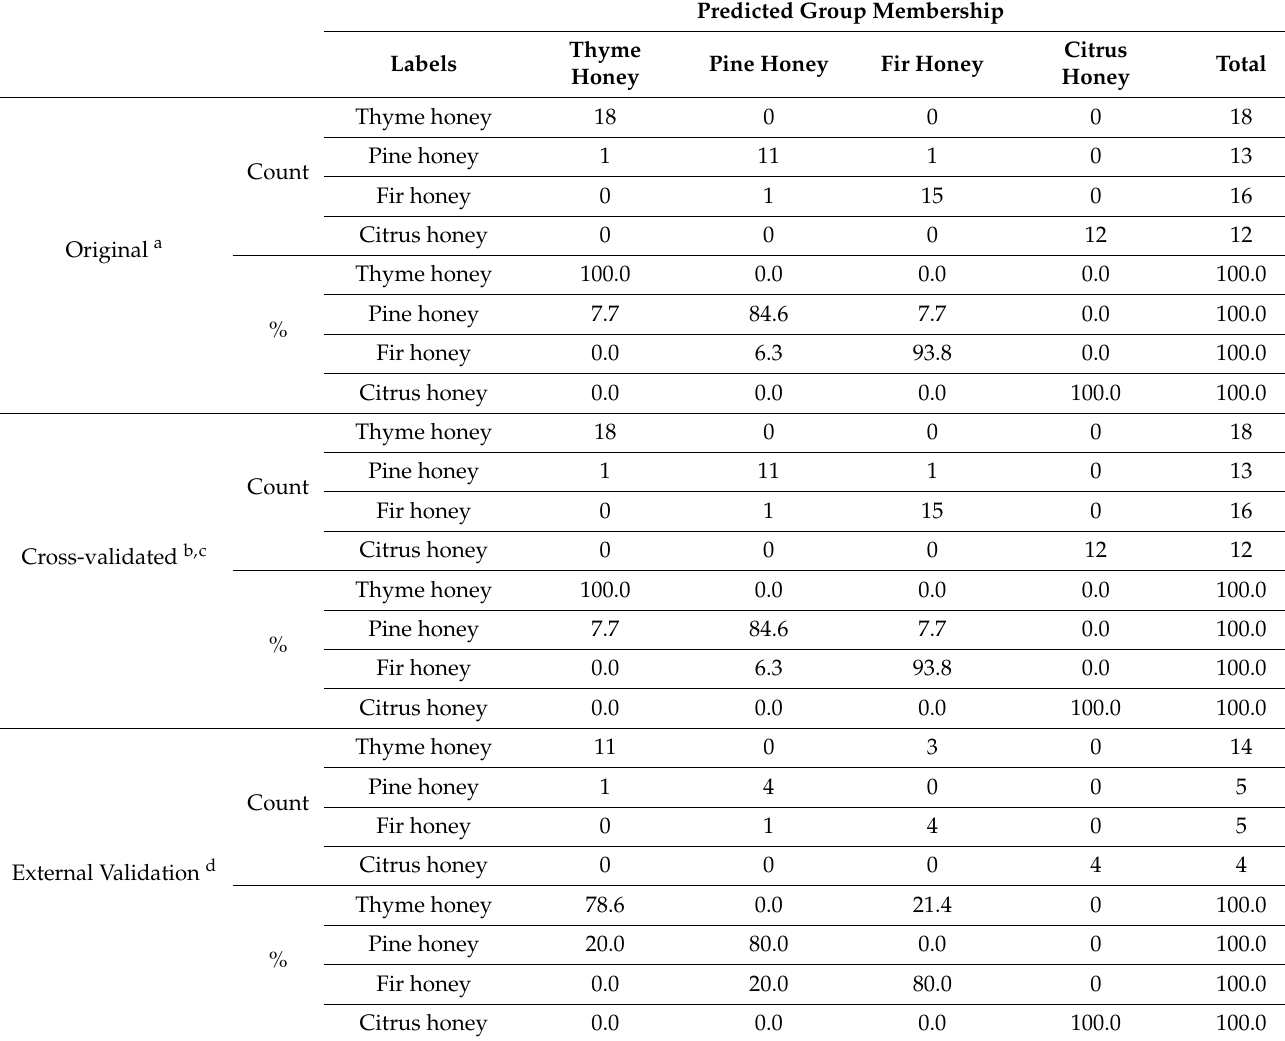
Table 3. Discrimination results based on fluorescence at λ ex = 330